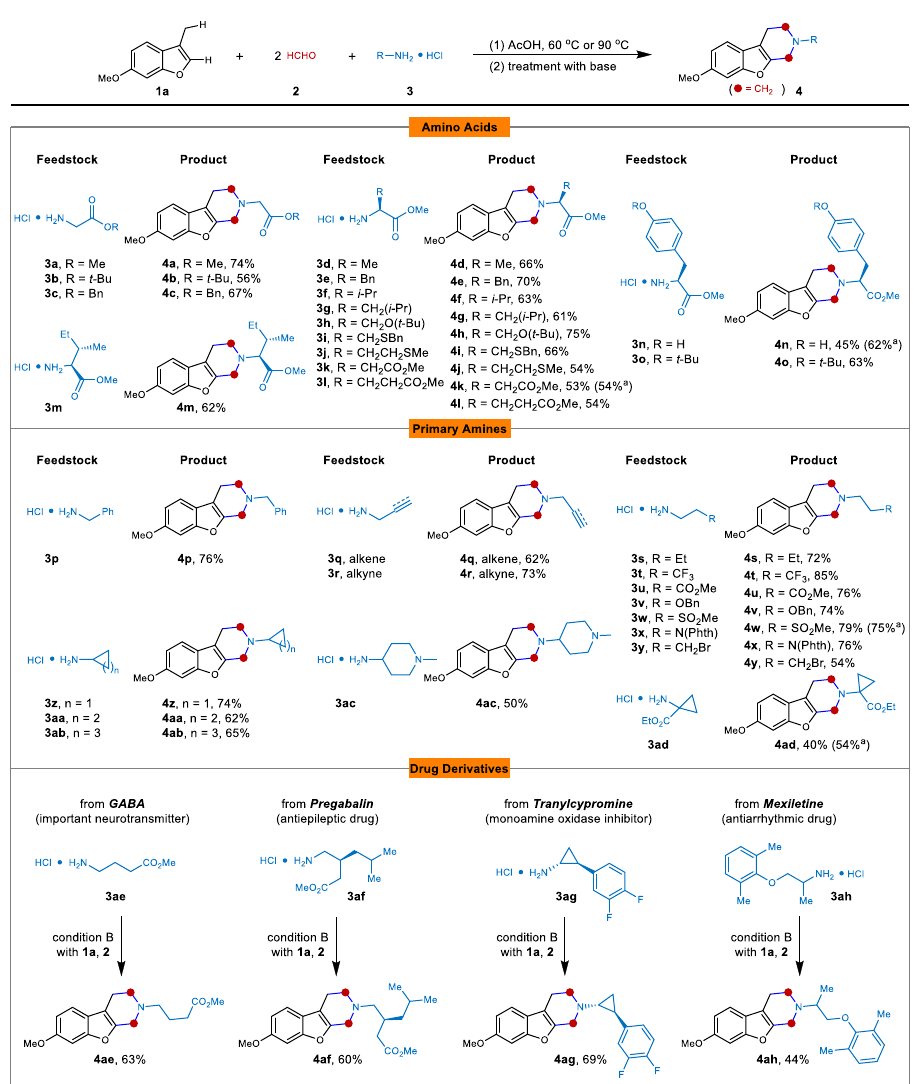
Fig. 3 Substrate scope of amines. Condition A (for 3a – 3o ): 1a (0.2 mmol), 2 (0.8 mmol), 3 (0.4 mmol) in AcOH (2 mL) at 60 °C, 3 h; Condition B (for 3p - 3ah ): 1a (0.2 mmol), 2 (1.6 mmol), 3 (0.8 mmol) in AcOH (2 mL) at 90 °C, 30 mins. Yields refer to isolated products. N(Phth) = N -phthalimide. a CH 3 CN (2 mL) as solvent, 8